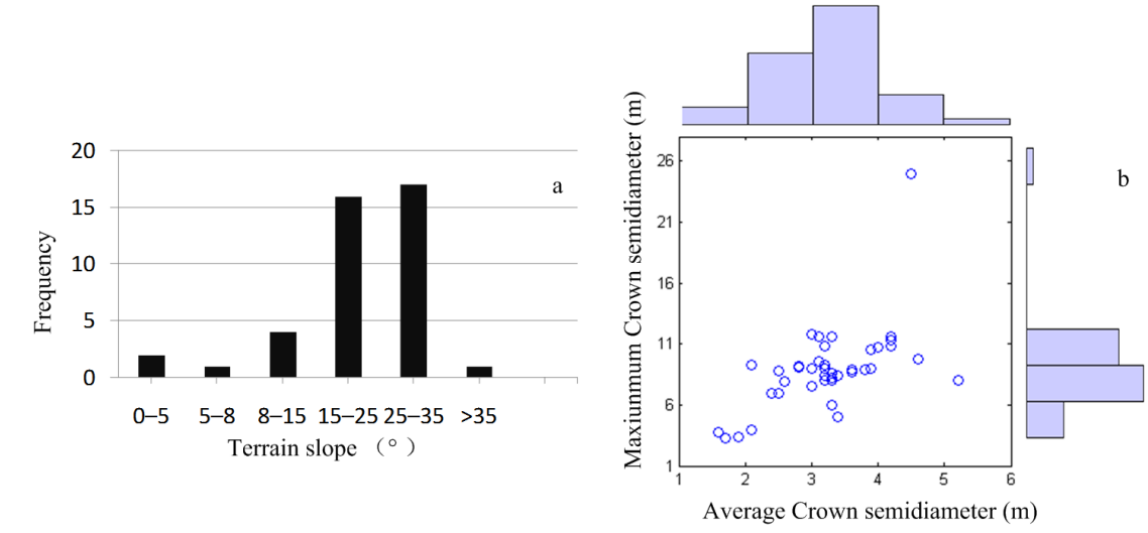
Figure 2. Distribution of terrain slope in the plots, average and maximum crown semidiameter. ( a ) terrain slope; ( b ) average and maximum crown semidiameter. Plot number 34, a broadleaf forest plot with S. superba , Mallotus paniculatus and Ficus variolosa as the dominant tree species, is cited again as an example. This plot had average elevation 562.4 m and average slope 31.2°. Field surveys detected a total of 98 trees, with an average height of 7.86 m (maximum, 13.5 m; minimum, 3.6 m). The average, maximum, minimum DBH of all trees were 9.2 cm, 37.0 cm and 5.0 cm, respectively, average crown at 4.1 m (maximum, 16.8 m; minimum, 1.5 m). The plot point cloud comprised 14,047